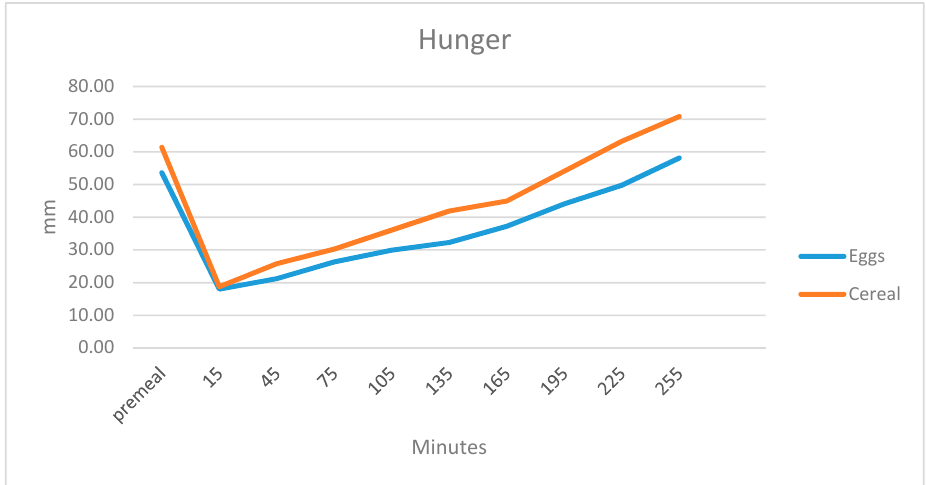
Figure 1. Subjective sensations of hunger before and 15, 45, 75, 105, 135, 165, 195 and 225 min after finishing breakfast on a 100-mm visual analogue scale (VAS).